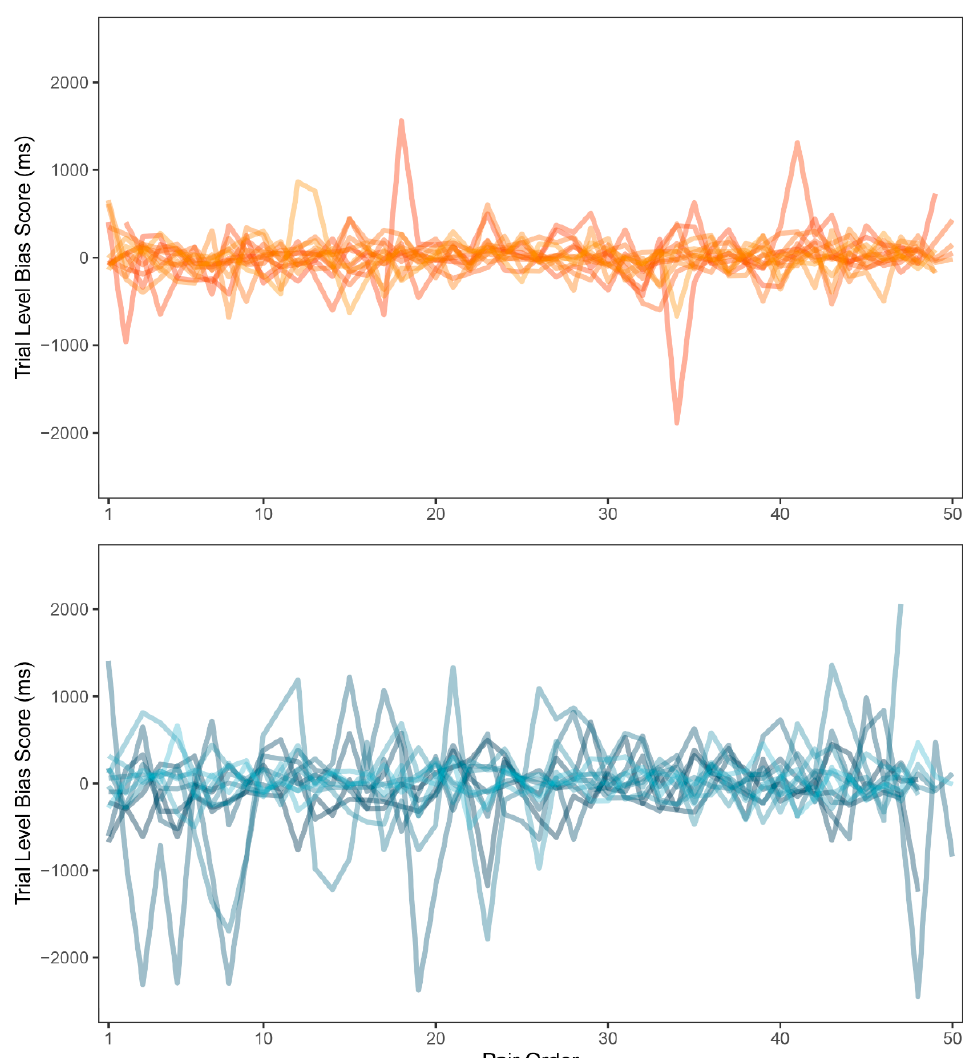
Figure 5. Trial level bias score (TL-BS) variability (ms) for control group ( top ) and experimental group ( bottom ).